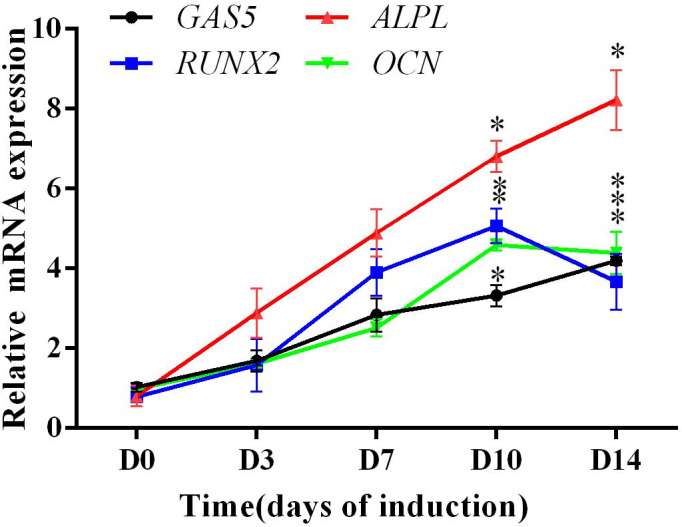
Gene marker expression of BMSCs osteoblast differentiation.Relative mRNA expression of GAS5, BGLAP, ALPL, and RUNX2 along with the day of human BMSCs osteogenic differentiation.